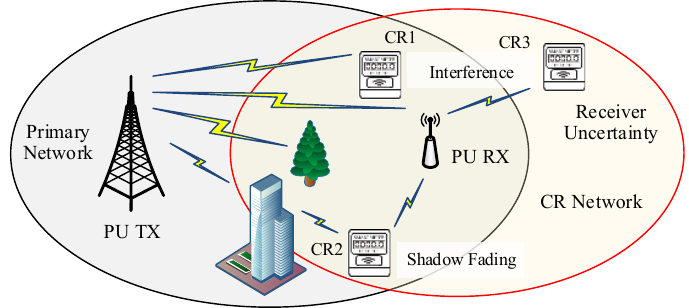
Figure 1. Issue of shadowing effect under smart grid environment.